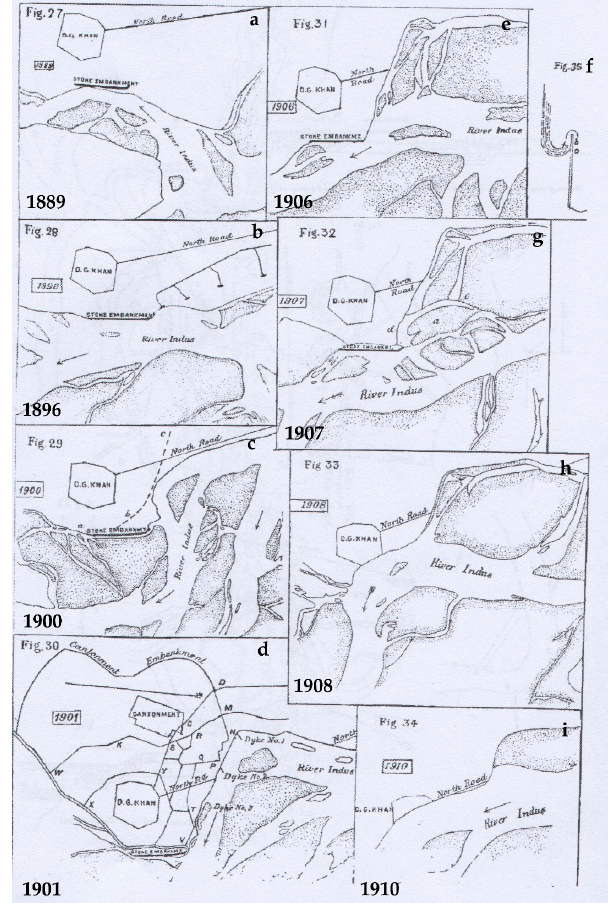
Figure 8. ( a – i ): Sketches showing the movement of the river between 1888 and 1910 [45]. ( d ) shows the protection system planned in 1901, which was already half lost in the 1907 SOI map. Note that the images are orientated West with North at right.